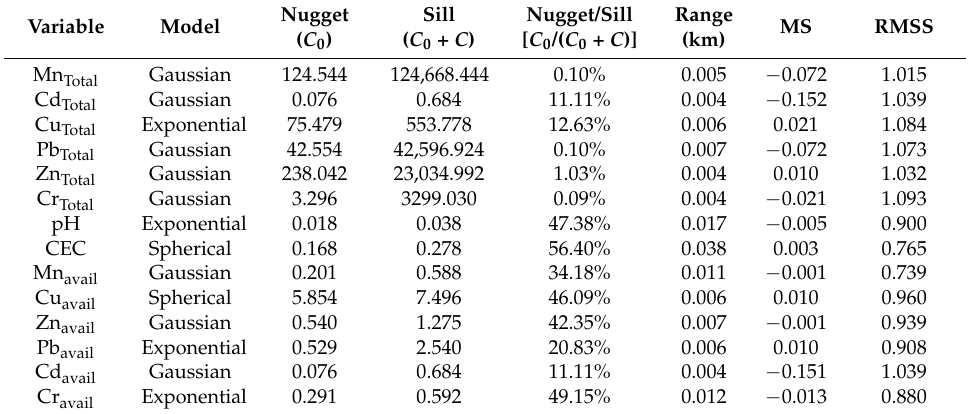
Table 7. The theoretical semivariogram models and the corresponding parameters for PHMs in